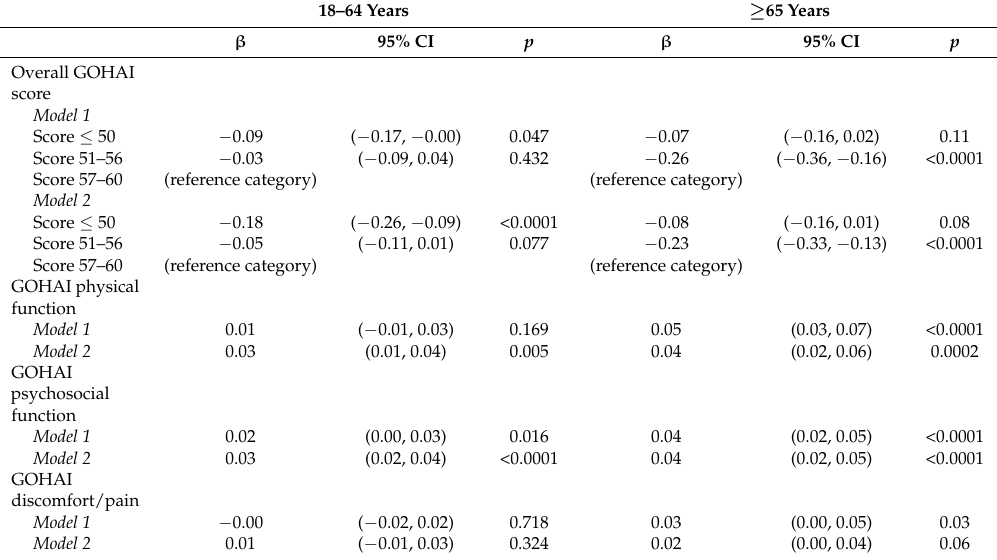
Table 3. Age-specific linear regression models of the association between oral health-related quality of life and diet quality (Etude NutriNet-Sant é , N =